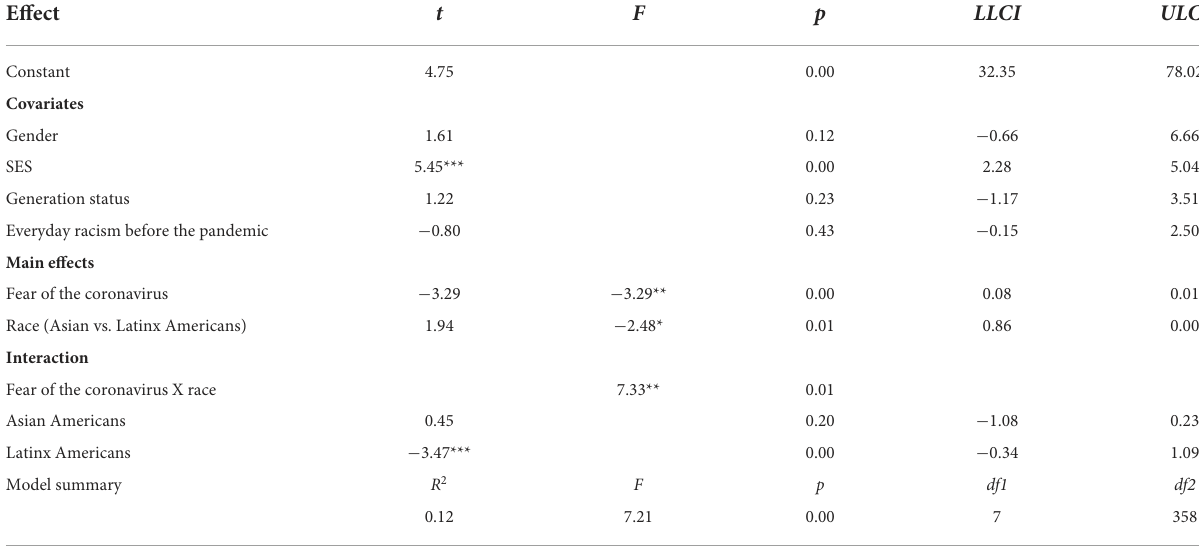
TABLE 4 Moderation results for fear of the coronavirus and race (Asian vs. Latinx Americans) with well-being as the outcome and everyday racism before the pandemic, gender, SES, and generation status as covariates for study 1. Effect